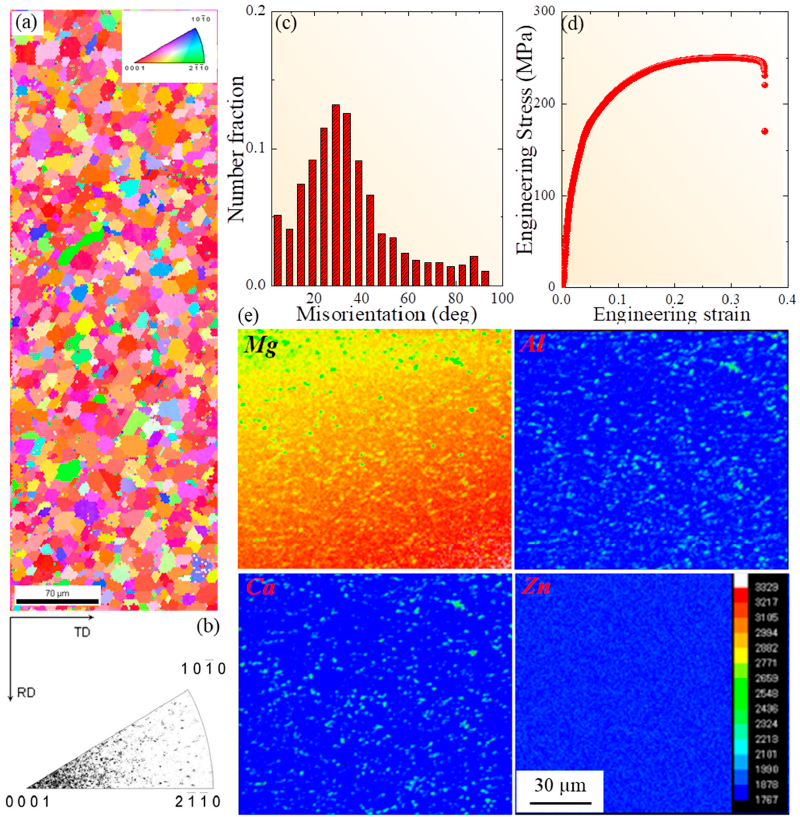
Figure 1. ( a ), ( b ) and ( c ) Inverse pole figure map, texture inverse pole figure, and misorientation angle distribution of the AZ31-Ca Mg alloy, respectively. ( d ) Room temperature tensile curve of the alloy. ( e ) Electron probe microanalysis maps of the alloy.